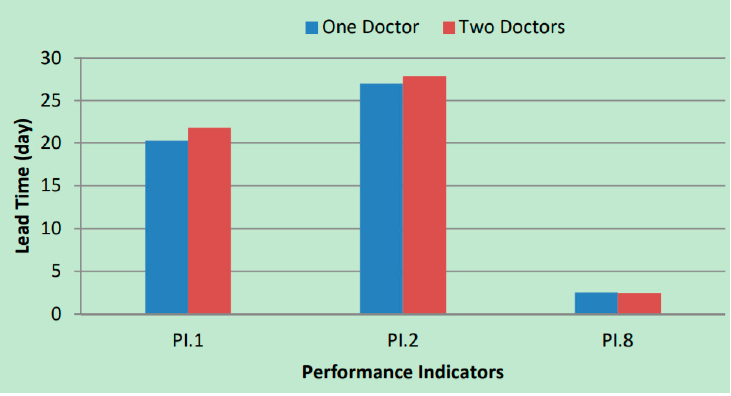
Figure 20. Effects of number of doctors on lead time.